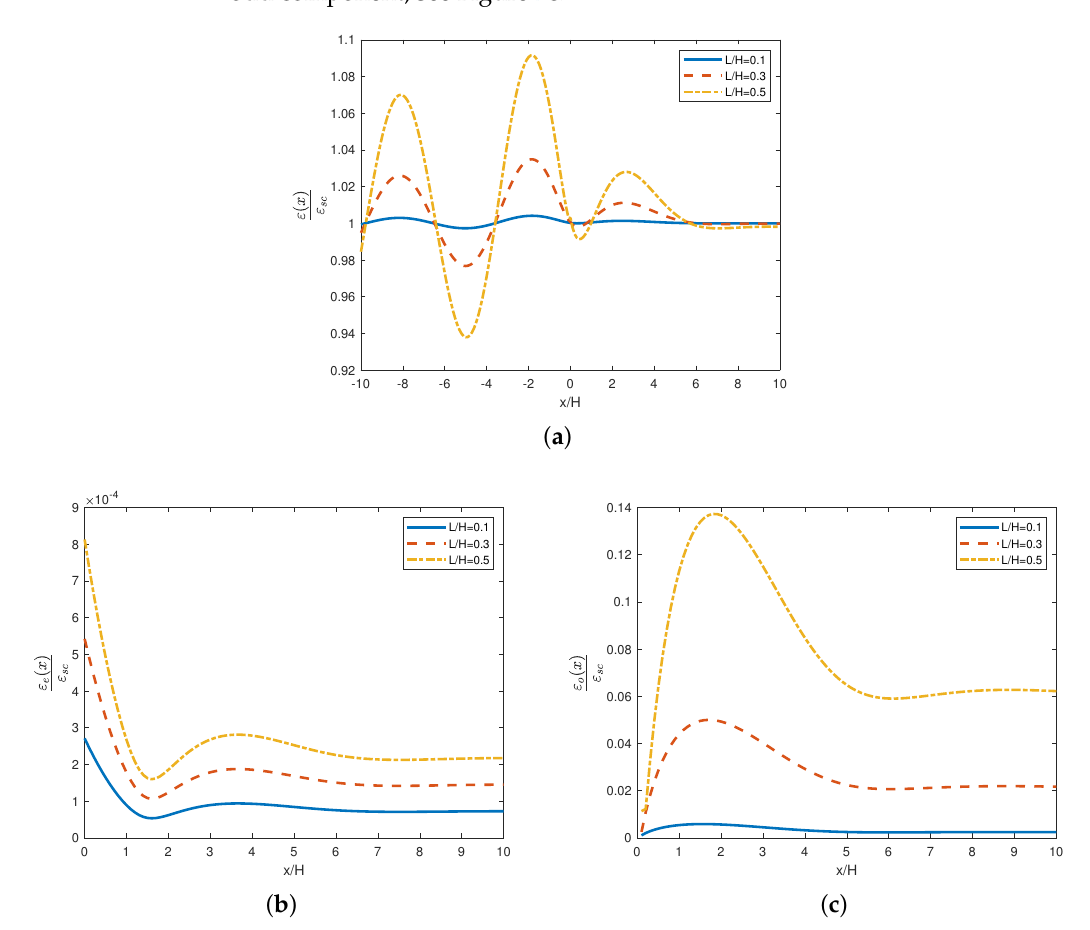
Figure 7. The scaled amplitudes of the total ( a ), even ( b ), | ε e ( x ) | / ε sc , and odd (c), | ε o ( x ) | / ε sc , components of the strain distribution in the floating plate for ω = 0.5 s − 1 and different lengths of the rigid plate. ( a ) Total strain. ( b ) Even strain. ( c ) Odd